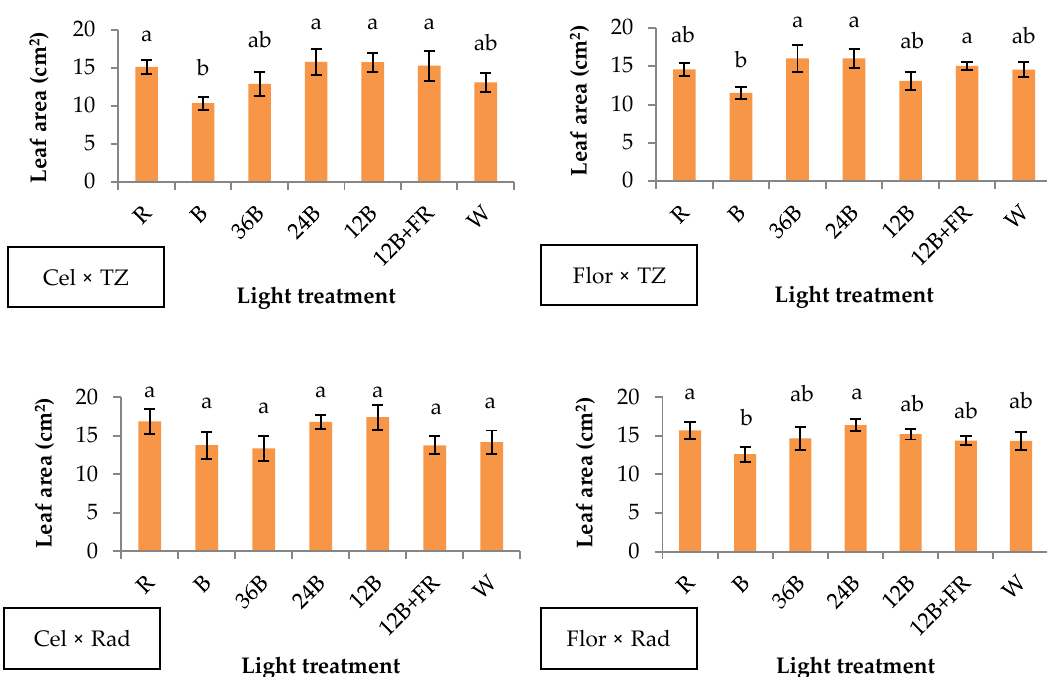
Figure 2. Leaf area of grafted watermelon seedlings derived from four watermelon × interspecific squash genotype combinations, and after illumination by seven light treatments during healing. Bars ( ± SE) followed by different letters are significantly different ( p ≤ 0.05).